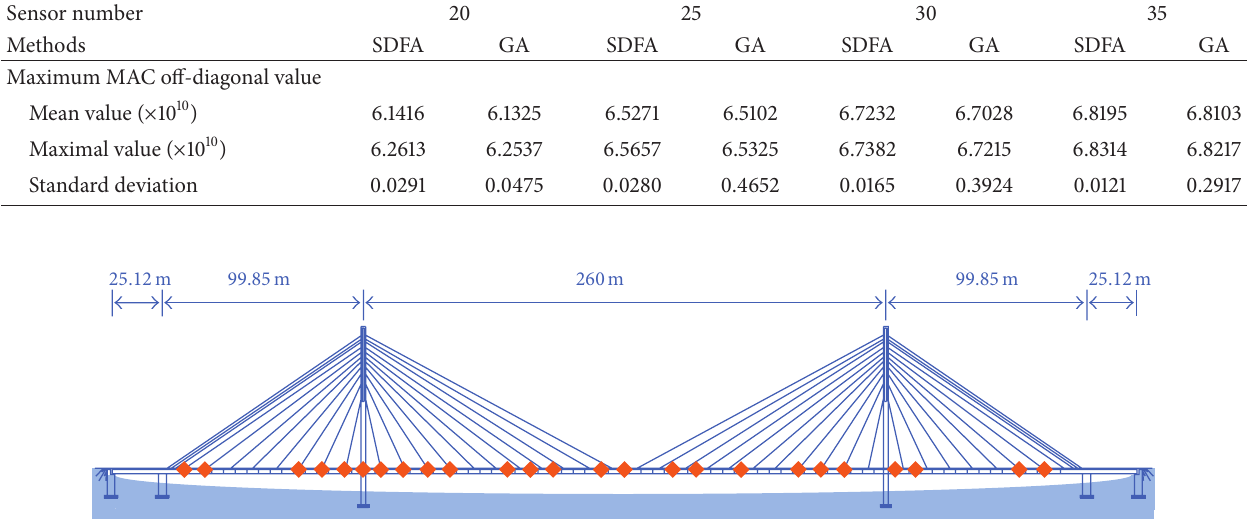
Figure 3: The optimal sensor configuration extracted by SDFA with the MSE.